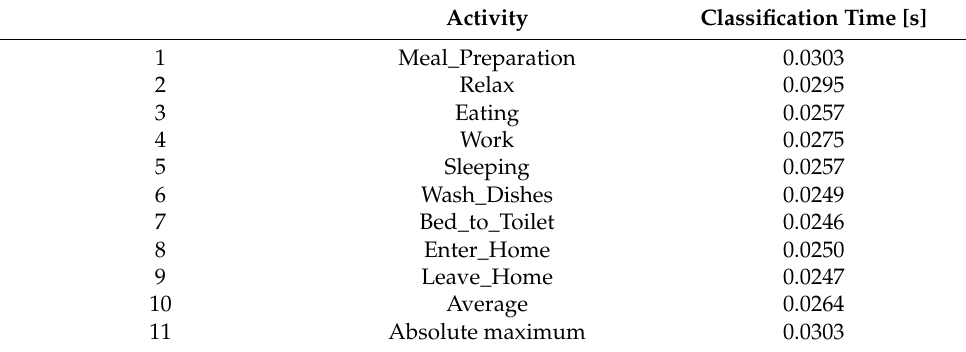
Table 8. Maximum Classification Latency for Each Activity.